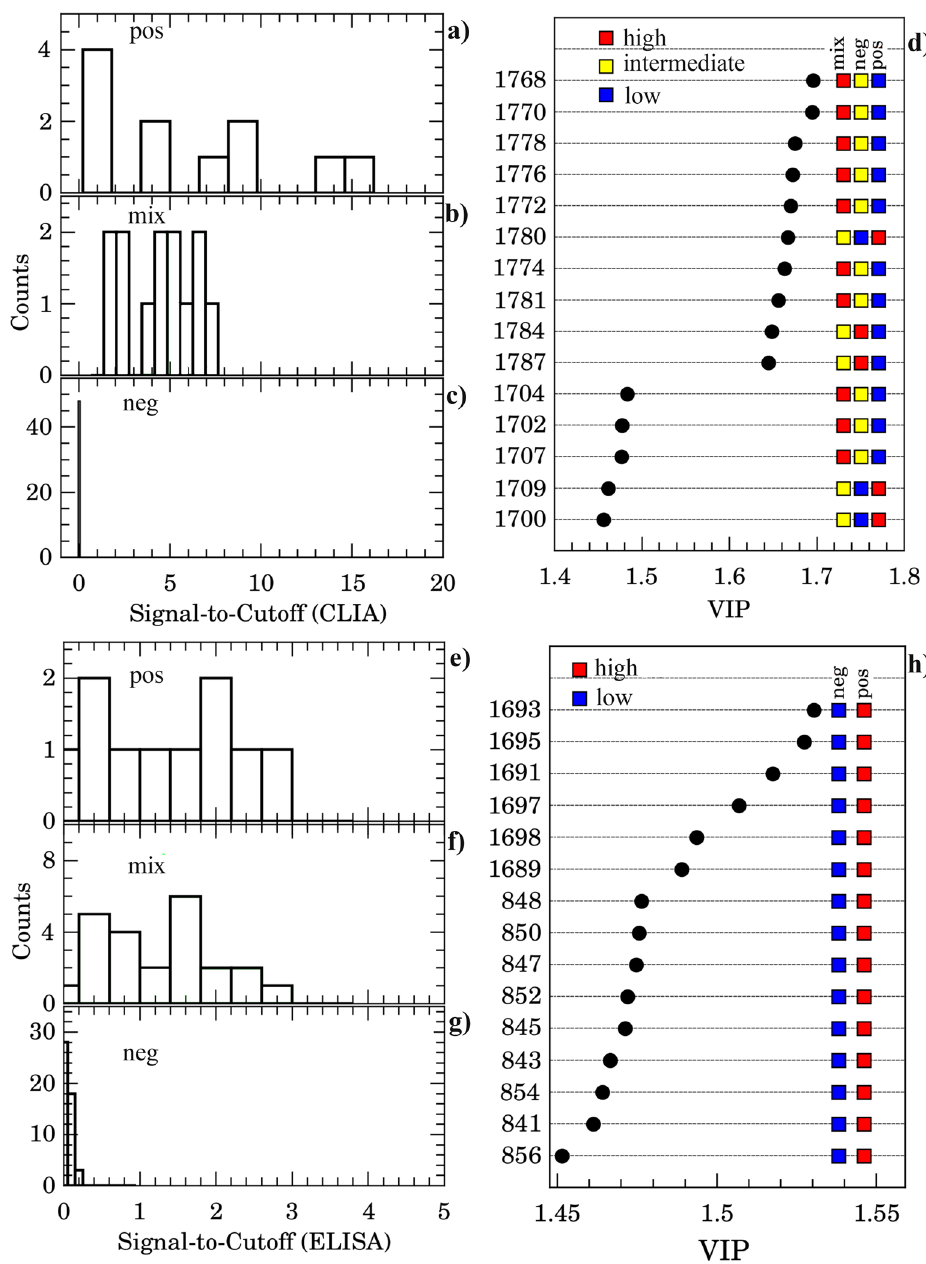
Figure 6. micro-FTIR and CLIA comparison. (a) – (c) Histograms of signal-to-cutoff data of CLIA IgG antibodies against Sars-Cov-2 for positive ( a ), mix ( b ), and negative ( c ) classes as discriminated by micro- FTIR. (d) Important vibrational frequencies (VIP) identified by PLS-DA for three classes classification. (e) – (g) Histograms of signal-to-cutoff data of ELISA IgG antibodies against Sars-Cov-2 for positive ( e ), mix ( f ), and negative ( g ) classes as discriminated by micro-FTIR. (h) VIP for two classes discrimination. Color boxes on the right of (d) , (h) indicate the relative intensity (high, intermediate and low) of the corresponding band in each